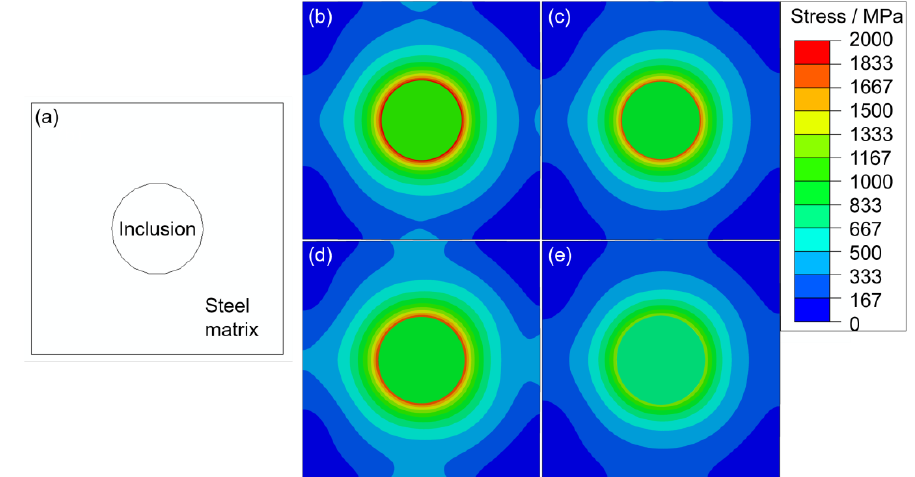
Figure 4. ( a ) Geometric illustration of the model for the residual stress simulation during cooling; residual stress distributions around the spherical inclusion of ( b ) Mg-Al-O; ( c ) Al-Ca-O-S; ( d ) TiN; ( e ) MnS.